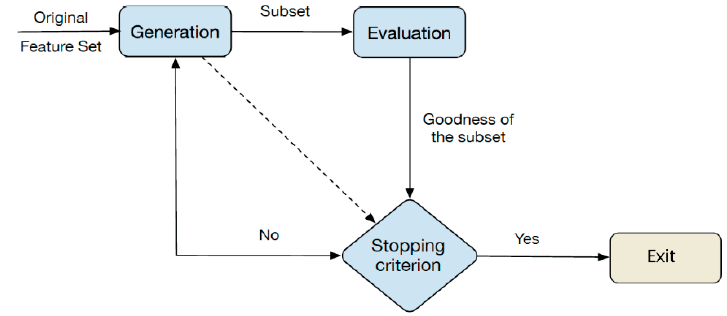
Figure 1. Scheme of a feature selection